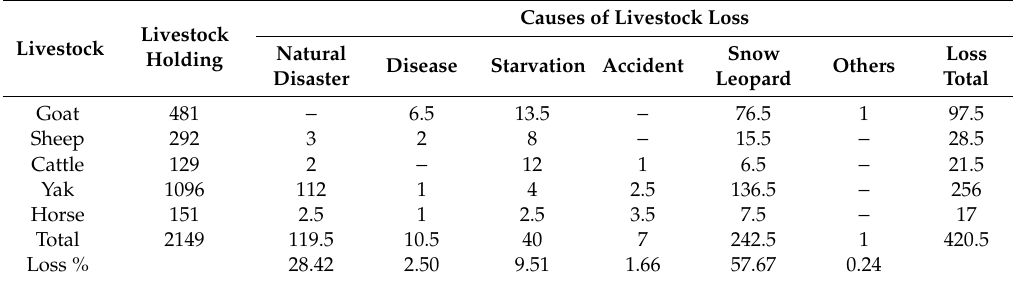
Table 1. Livestock holdings and loss among sampled households ( n = 65) in Narphu valley during years 2017 / 18 and 2018 /